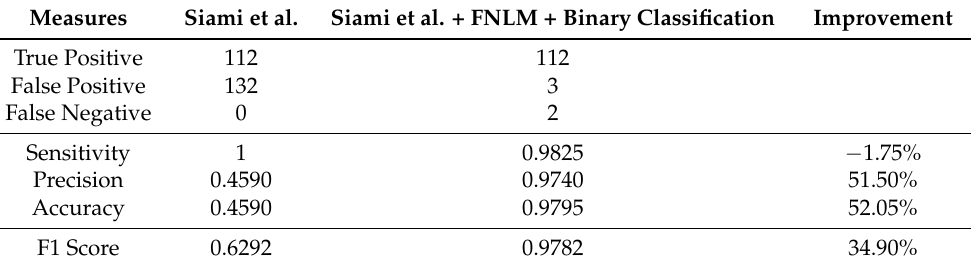
Table 4. Comparison of the precision, recall, and F1 score metrics for overheated idler detection in IR images using binary classification and Siami et al.’s work